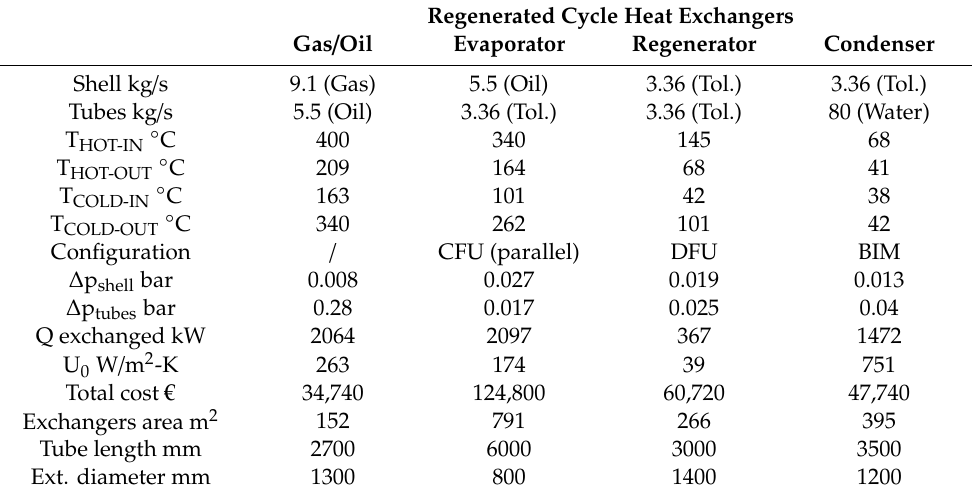
Table 4. Main exchangers